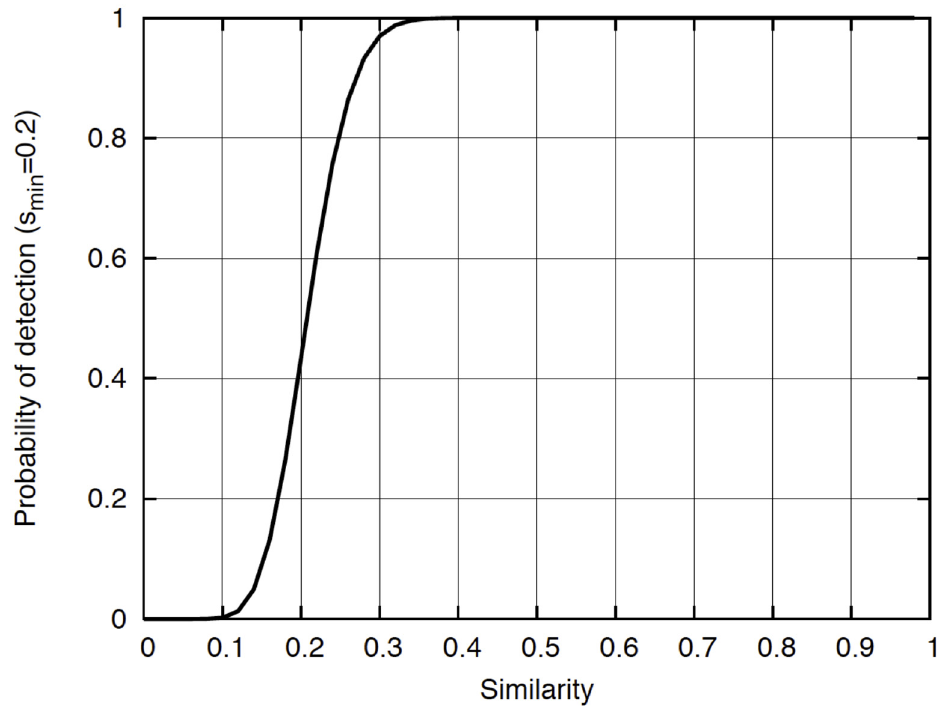
Fig 11. Variation of query identification probability with respect to similarity. An arbitrary threshold of 0 . 2 is selected. s min =